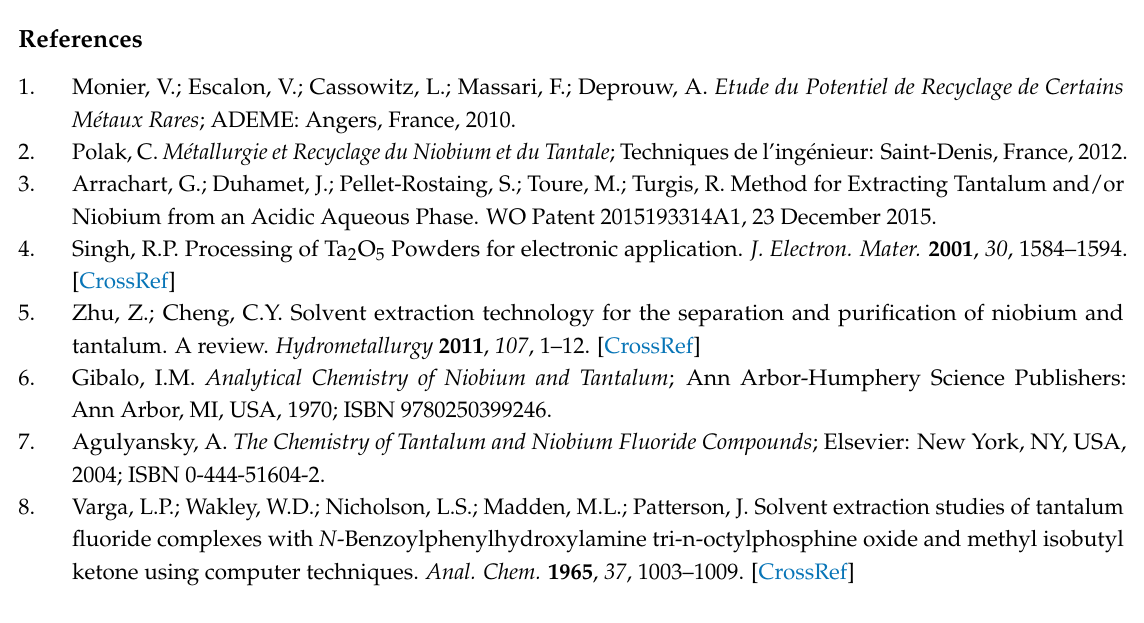
Table S1: D and SF Ta/Nb values for Ta and Nb for 4-MAcPh and MIBK. Table S2: D values for Ta, Ni, Mn, Fe and Ag as a function H 2 SO 4 of